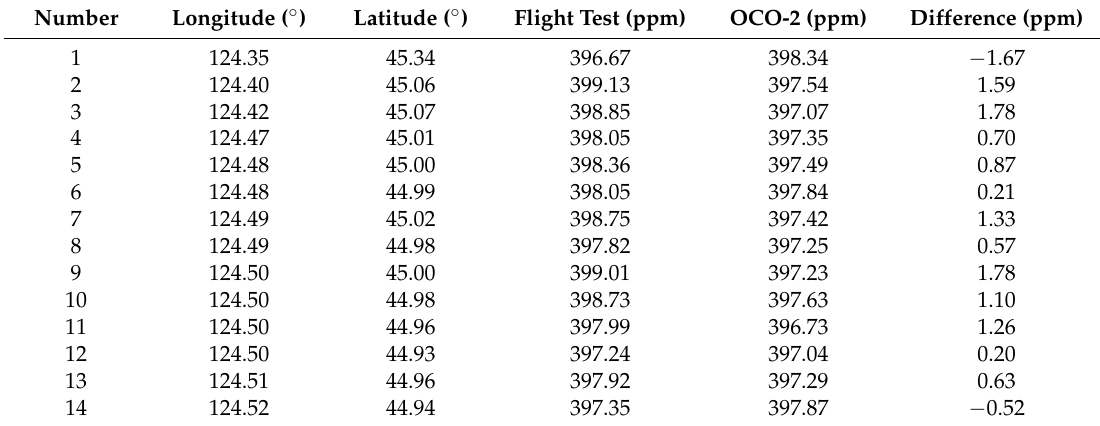
Table 6. The XCO 2 difference between HASM and OCO-2 estimates in the flight test